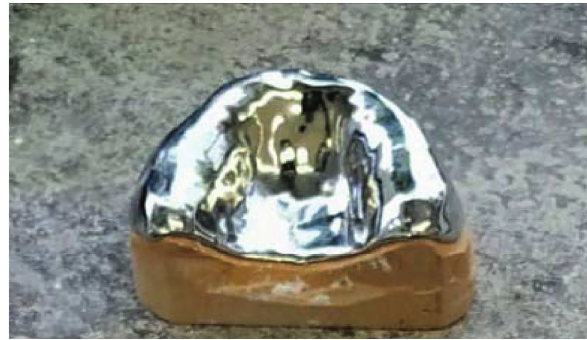
Figure 4: Prefabricated